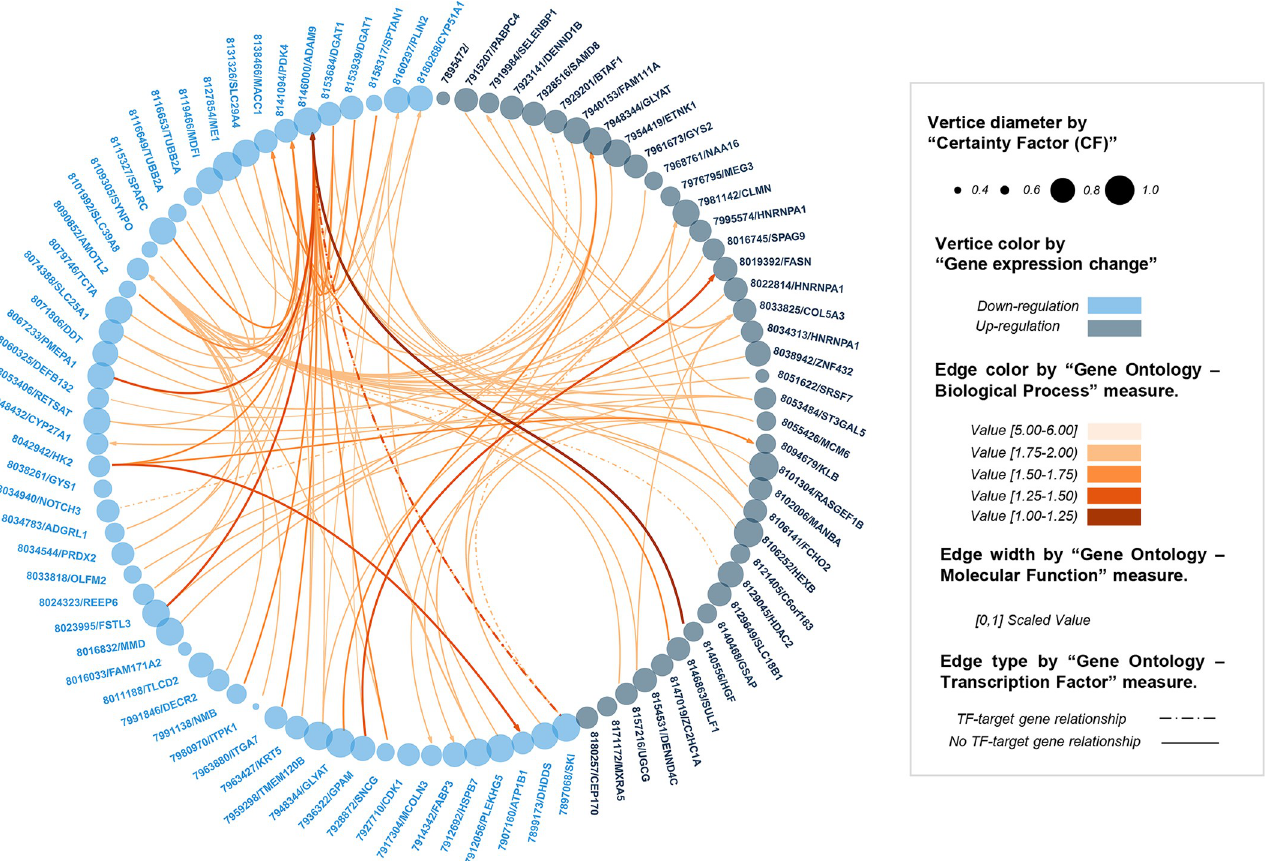
Fig 4. Visual representation of the sequential rules discovered by our method in the GSE77962 dataset (VLCD group). Node names refer to (probe/gene).